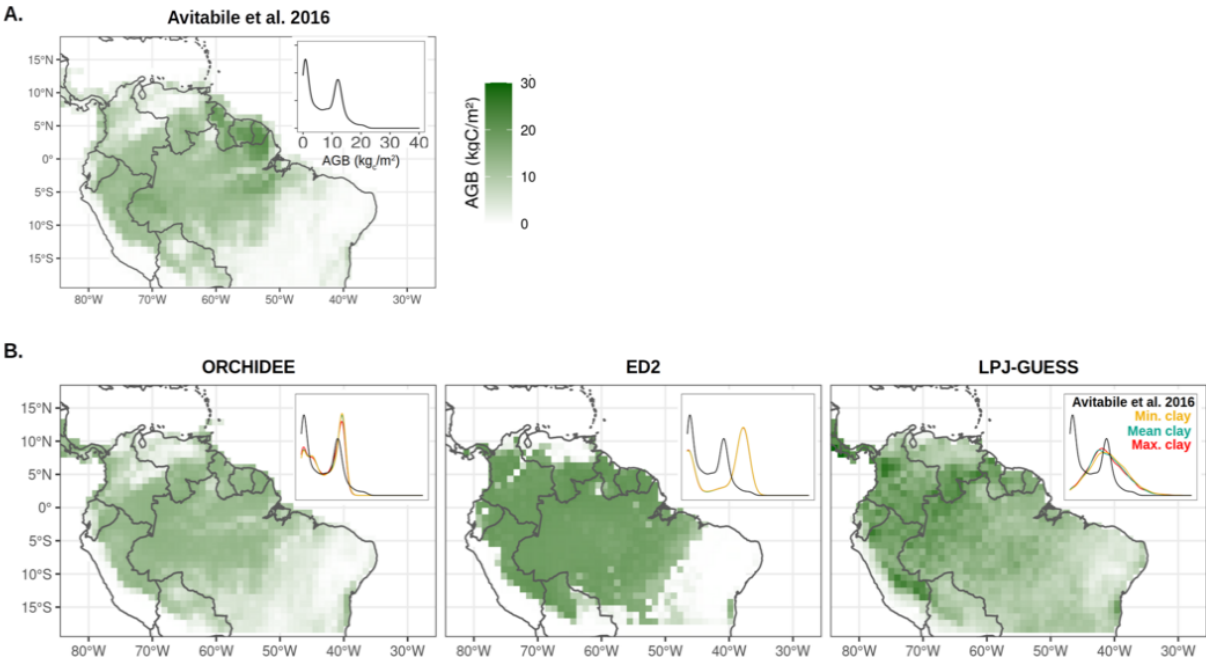
Figure 2. Aboveground biomass (AGB) spatial distribution, as generated by Avitabile et al. (2016) (a) or as predicted at the end of the historical period (average over the 2006–2016 period) by the three terrestrial biosphere models used in this study for the Mean clay scenario (b) . The upper-right corners in each plot represent the AGB density distributions over the simulated region for all three scenarios (coloured lines) and the observations (black). Note that the land cover was prescribed in the ORCHIDEE model, while it was an emergent property of the ED2 and LPJ-GUESS models.